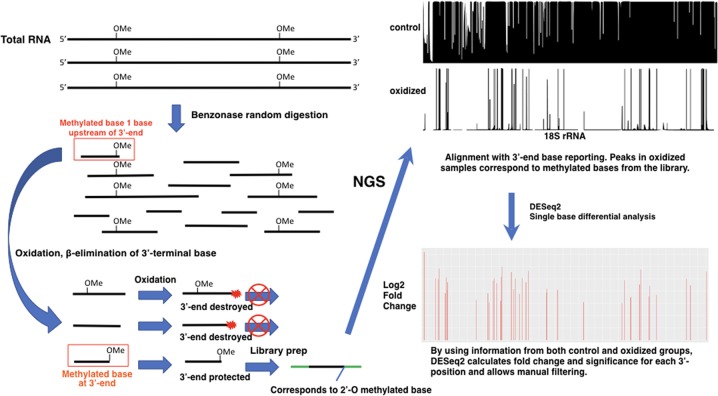
Work flow of the RibOxi-seq method. As shown on the left, rRNAs are digested randomly with Benzonase to generate RNA fragments that have 2′,3′-OH ends. Because the fragments are relatively small, some of those containing 2′-OMe will have methylated bases near their 3′-ends. β-Elimination is performed on the RNA fragments from the previous step to expose ribose methylated bases to the very 3′-ends. The resulting RNA pool is then oxidized so that fragments with methylated bases at the 3′-ends are protected. The fragments with ribose methylated bases at the 3′-end are available for linker ligation and are therefore enriched for RNA-seq library construction. After sequencing, data are processed and mapped to visualize the alignment of 3′-end bases to a reference genome in the UCSC Genome Browser (top right). The data are statistically analyzed using DESeq2 for enrichment, and significance for each base position is shown in the bottom right. (Boxed in red) Fragments susceptible to sequencing.